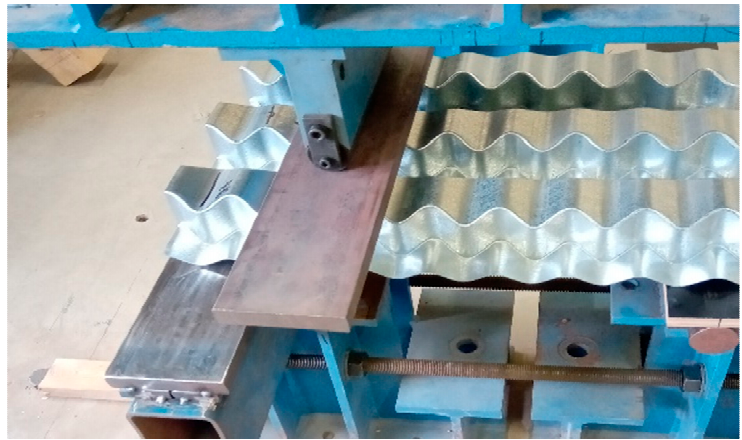
Figure 10. End span test.